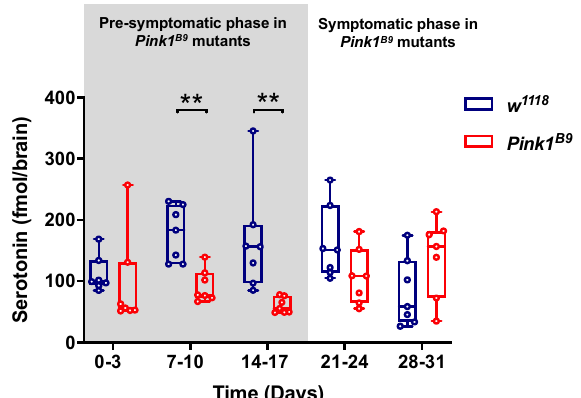
Figure 1. Pink1 B9 mutants exhibits lower 5-HT brain content during the pre-symptomatic phase. Serotonin content in brains of Pink1 B9 mutants and w 1118 control flies throughout adult life, measured by HPLC coupled to an electrochemical detector. Seven independent measures per time window are shown; each measurement corresponds to 5 brains (35 brains in total per genotype). Data represent the interquartile range with maximum and minimum ranges. ** indicates p < 0.01, when comparing genotypes. Scheirer-Ray-Hare test followed by Dunn’s post hoc test. Pre-symptomatic (gray background) and symptomatic phases of Pink1 B9 mutant flies are indicated.